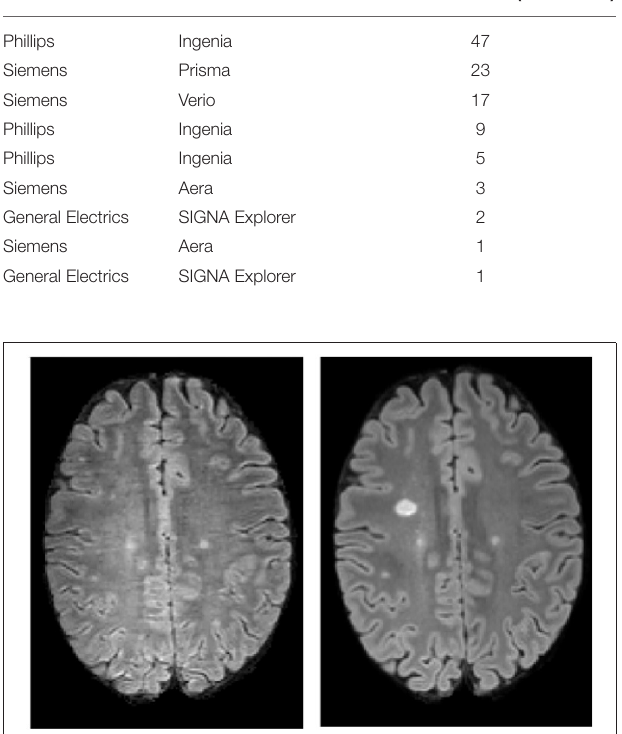
FIGURE 4 | A pair of FLAIR acquisitions from a patient of the evaluation dataset experiencing a low quality baseline scan. (Left) Baseline FLAIR axial slice. (Right) Follow-up FLAIR axial